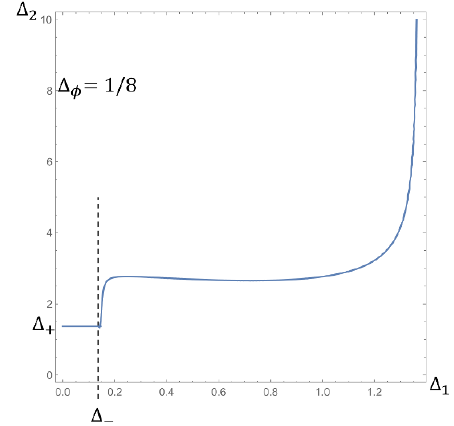
Figure 16 . Constraints on the (cid:12)rst two primary operators ((cid:1) 1 ; (cid:1) 2 ). The region below the blue line is allowed. Before the dashed line, (cid:1) 1 < (cid:1) (cid:0) and hence (cid:1) 2 must be smaller than (cid:1) + . After the dashed line (cid:1) (cid:0) < (cid:1) 1 , then (cid:1) 2 must be below the curve there are no solutions and is ruled